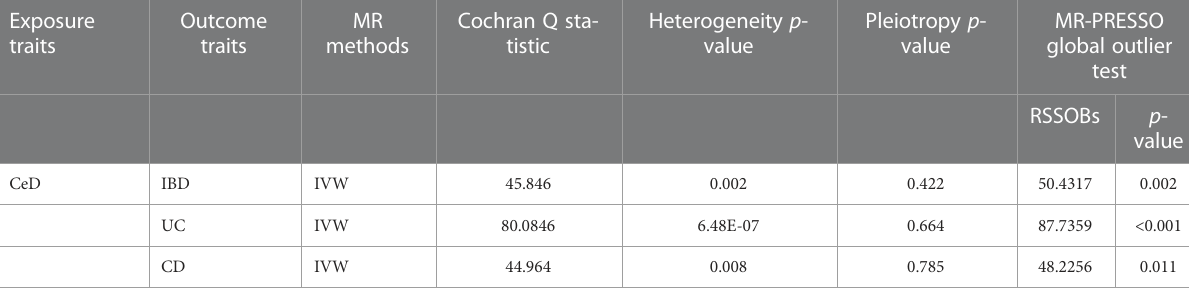
TABLE 2 Heterogeneity and pleiotropy analysis of CeD with IBD, UC, and CD using different analytical methods. Exposure